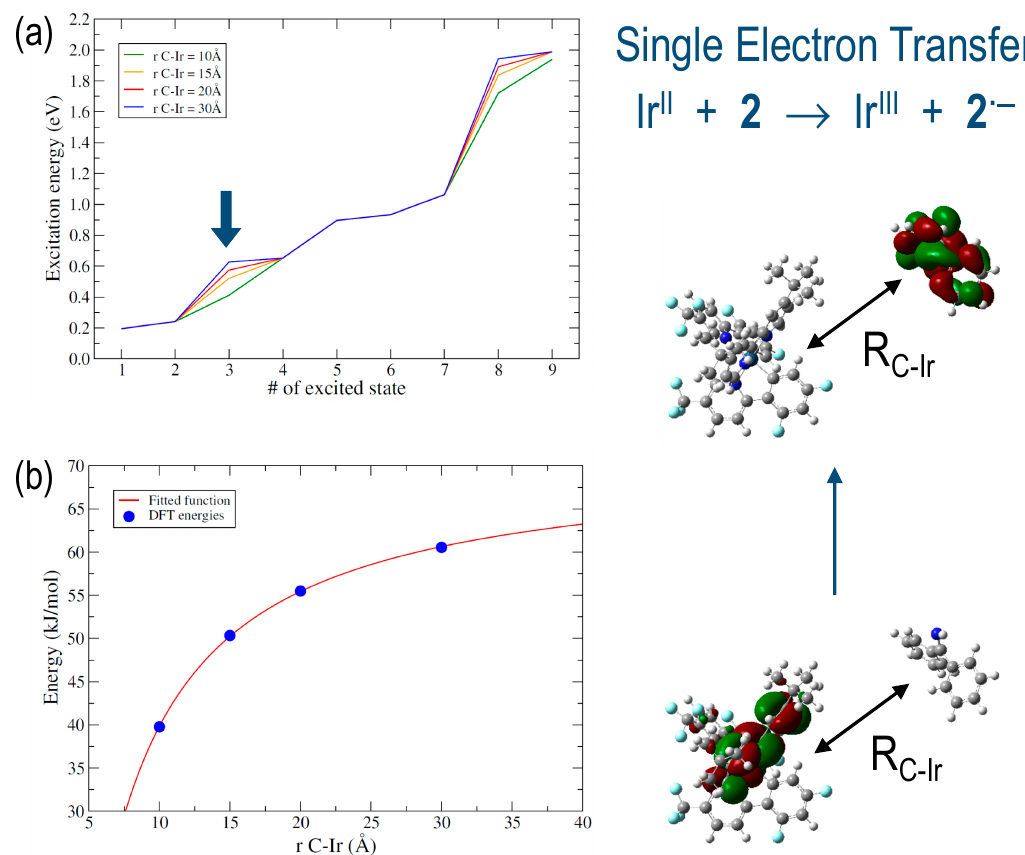
Figure 2. ( a ) Excitation energy of the first ten states in the [ Ir II . . . 2] complex at several distances calculated with TD-DFT. Excited state number three (highlighted with a blue arrow) is a charge-transfer state that corresponds to the redox reaction to form ( Ir III ) + and radical 2 · − . ( b ) TD-DFT energies of excited state three in panel ( a ) (blue circles) and fitted function E(r) = A − B/r (red line) showing the Coulomb stabilization of the redox reaction as a function of the photocatalysts imine distance.